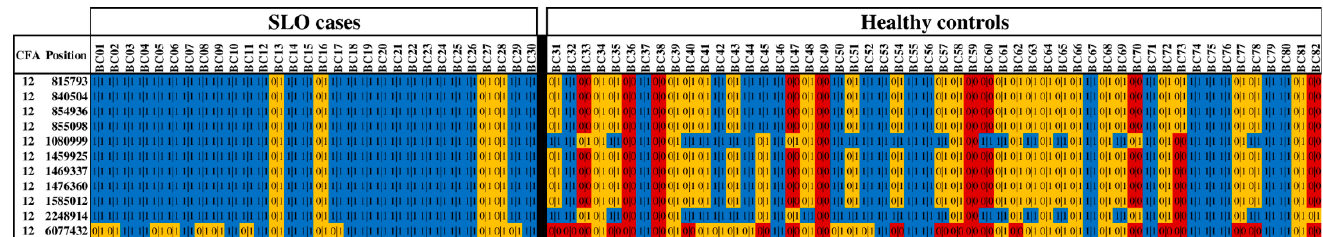
Figure 3. Genotypes for the 11 variants of interest on canine chromosome 12 in 82 unrelated Bearded Collies (30 SLO and 52 healthy controls). Dogs were sorted by SLO status; the homozygous reference genotypes (red) are notably absent in the SLO dogs, which predominantly carry homozygous non-reference (blue) genotypes. Heterozygous genotypes are colored in yellow. Variant locations are based on the CanFam3.1 reference genome. CFA—canine chromosome; SLO—symmetrical lupoid onychodystrophy.